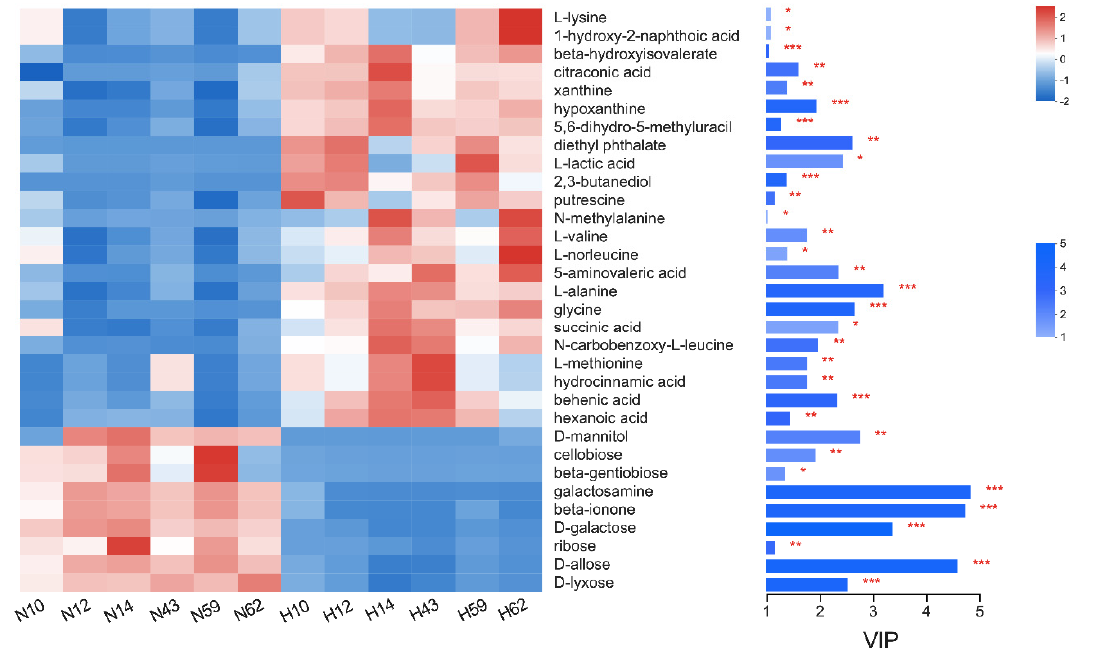
Figure 3. Differential metabolites in rumen fluid of buffalo under non-heat stress and heat stress conditions. The heatmap is the metabolite expression and the right side is the metabolite variable importance in projection (VIP) bar graph. The color of the bar indicates the significance of the difference between the two groups of metabolites, * represents p < 0.05, ** represents p < 0.01, *** represents p < 0.001. N, non-heat stress condition; H, heat stress condition.